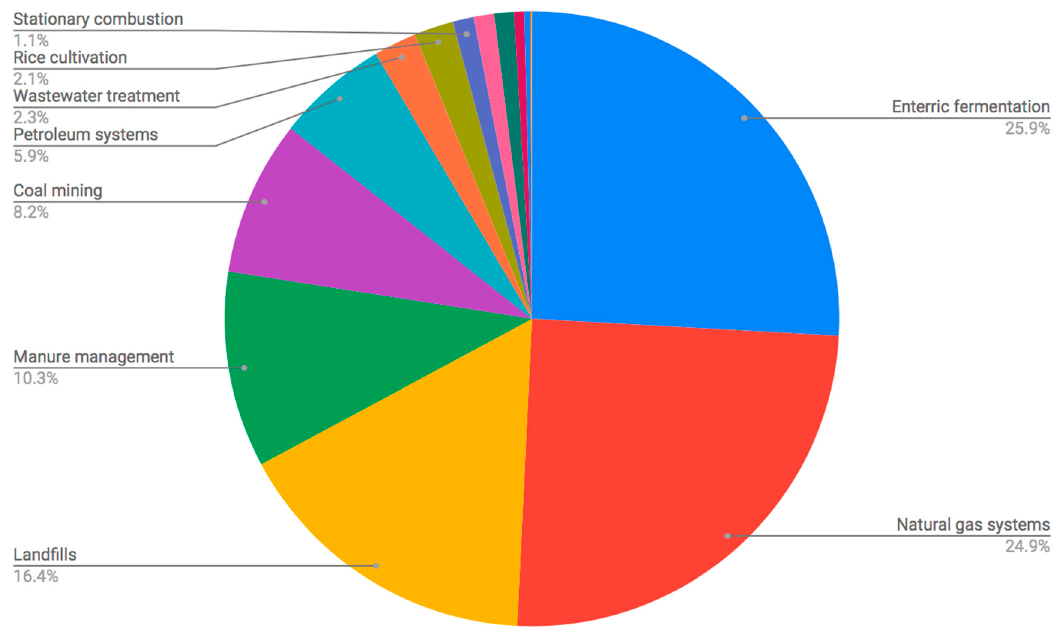
Figure 1. The 2015 methane emissions sources in the United States by percentage [4].